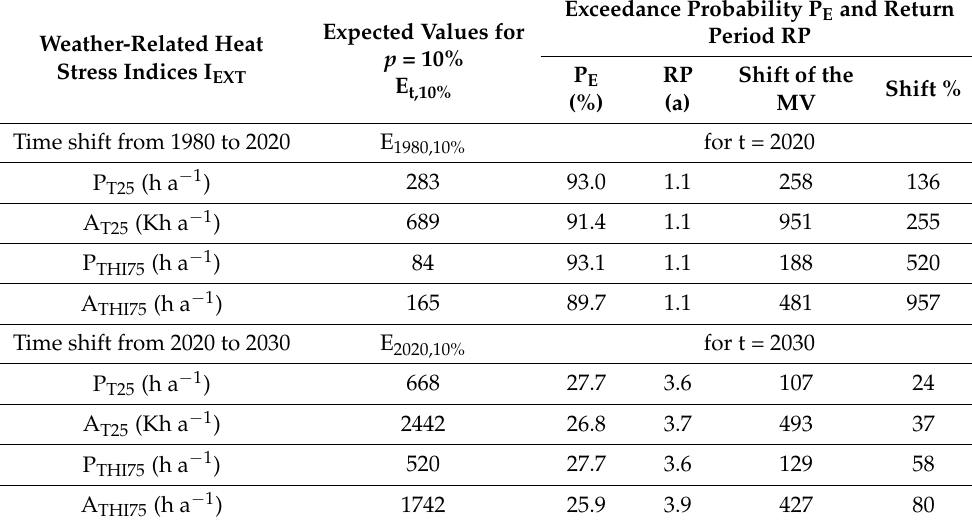
Table 6. Exceedance probability P E and return period RP using the 90-percentile p CDF = 90% (P E = 10%) of the cumulative distribution function. The time shift was calculated for the past t = 1980 and t = 2020, and the near future t = 2020 and t = 2030. The shift of the mean values MV (expected value of the HS index for an exceedance probability of 50%) shows the consequence of global warming.